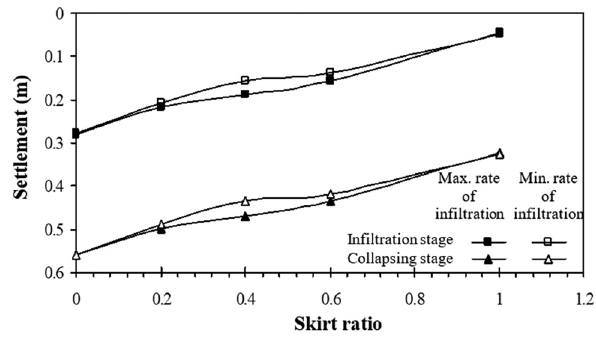
Figure 7: Correlation between settlement and skirt